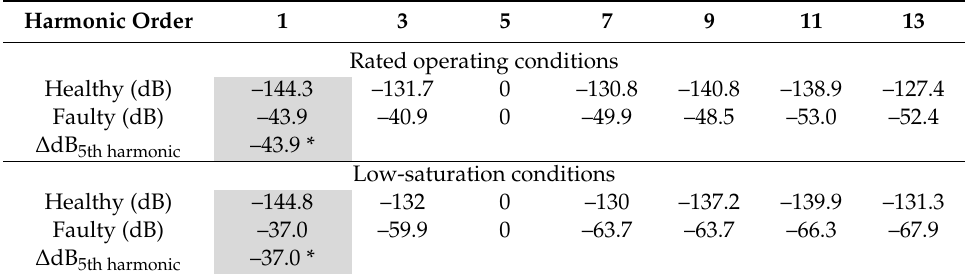
Table 4. ZSVC harmonics. Amplitudes of the harmonics under healthy and faulty conditions with only one shorted